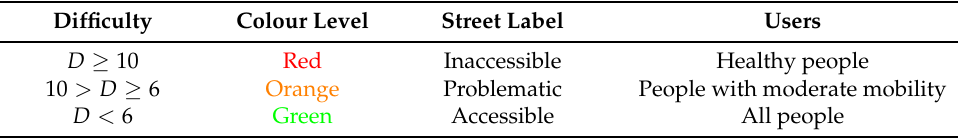
Table 3. Three accessibility levels of a